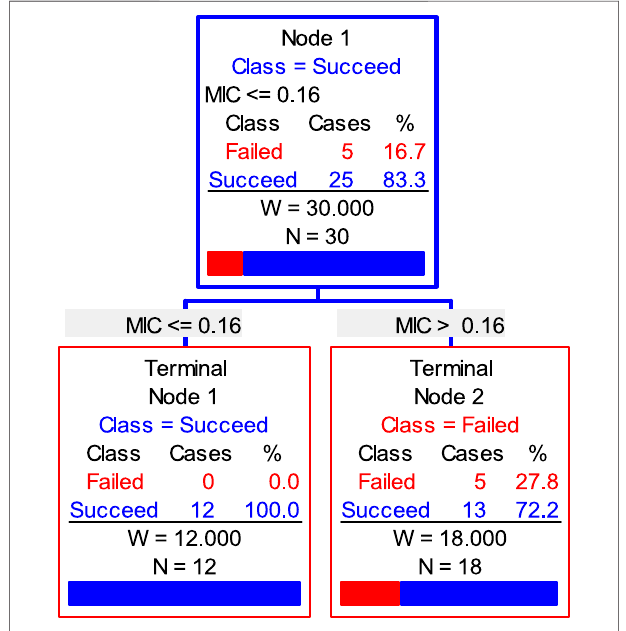
FIGURE 6 | CART tree showing values of clinical